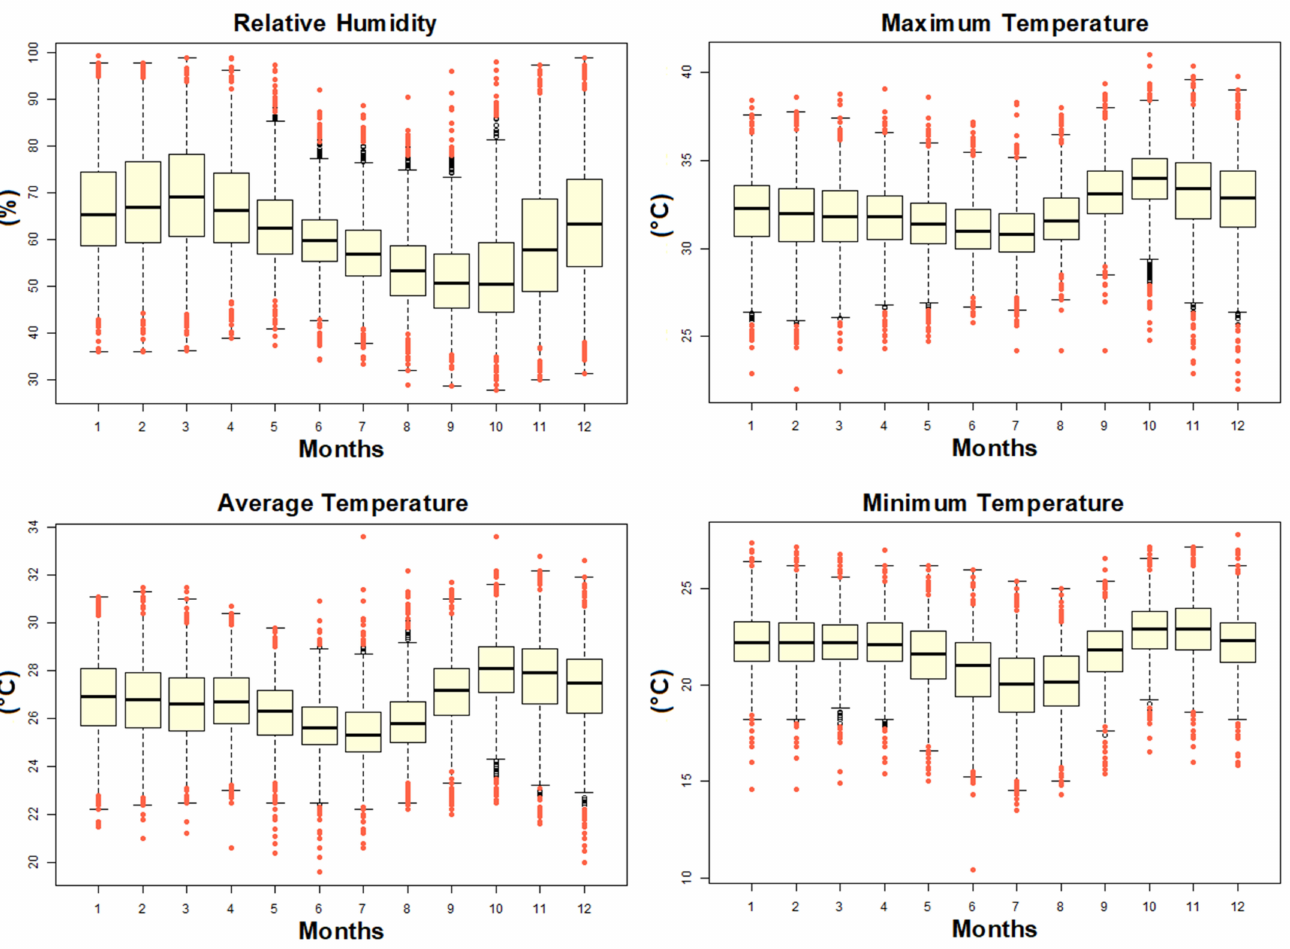
Figure 11. Variable limits test results for the 1% and 99% percentiles for the variables that are identified on the top of each graph. Red dots indicate the values that exceeded these